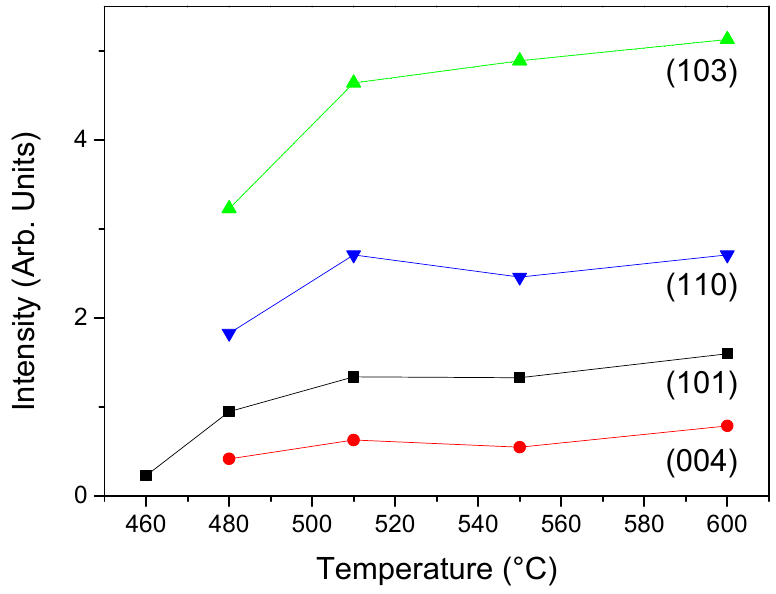
Figure 2. Evolution of the diffraction peak intensity as a function of the annealing temperature for the (101), (110), (103), (004) peaks on the tetragonal form of La 2 CuO 4 .